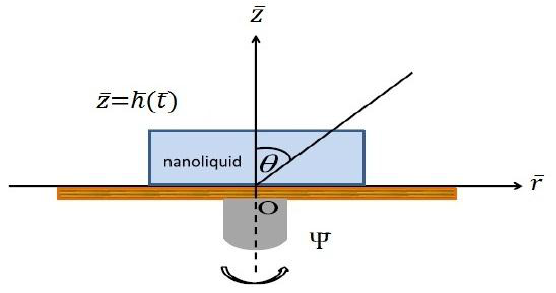
Figure 1. Physical configuration of the rotating disk.